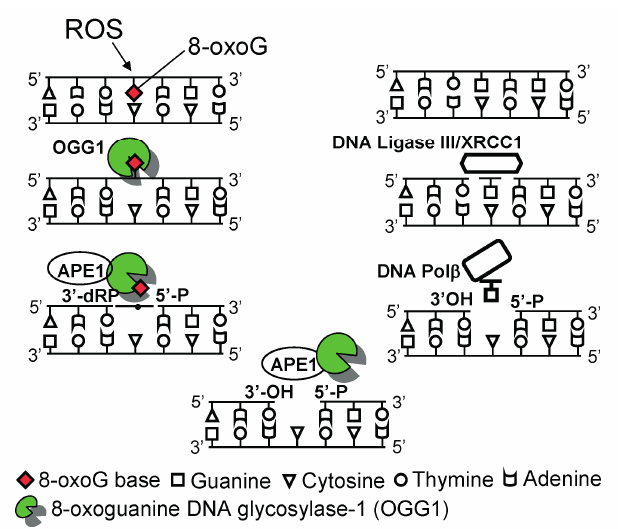
directly, generating an apurinic/apyrimidinic (AP)-site(s). Apurinic / apyrimidinic endonuclease 1 (APE1) processes the single-strand gap by removing the 3'-phospho- α , β -unsaturated aldehyde residue to form a 3'-OH end. DNA polymerase β inserts guanine, and the nicks are ligated by ligase II/XRCC1. AP site, apurinic/apyrimidinic site; APE1,